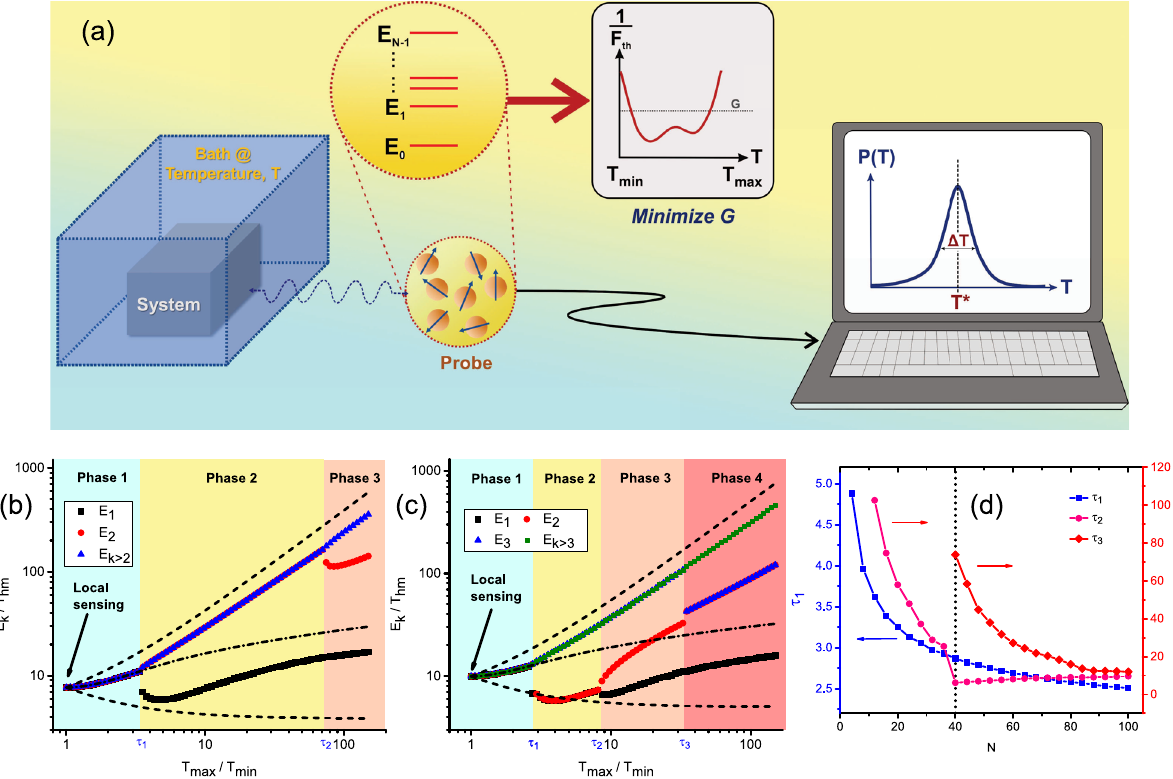
Fig. 1 Global quantum thermometry. a Schematic of our proposal. A probe weakly interacts with the system and thus reaches an equilibrium at the system temperature T 2 ½ T min ; T max (cid:3) . The probe equilibrium state is characterized by a certain energy spectrum with levels E 0 … E N − 1 with N being the number of energy levels. The energy spectrum also determines the thermal quantum Fisher information F th as a function of T . The global thermometry measure G , de fi ned in Eq. (4) as the average uncertainty of the probe, is a property of the probe energy spectrum, and is minimized to achieve the optimal probe. Energy measurements on the probe yield a probability distribution of temperatures with an estimated temperature T * and variance ( Δ T ) 2 . The optimal energies against temperature ratio T max = T min for a general N -level system are obtained for: b N = 16, with E k >2 denoting the degenerate energy levels E = ⋯ = E N − N = 64, with E k E = ⋯ = E N − 3 1 . c >3 denoting the degenerate energy levels 4 1 . In ( b ) and ( c ), the energies are scaled with the characteristic temperature T hm , where T hm is the harmonic mean of T min and T max . The leftmost data point corresponds to the case of the locally optimal thermometer. The dashed lines indicate the approximate bounds for the energies (explained in main text), while the dash-dotted line shows the optimal energy gap for an effective two-level system. The different phases indicate a sudden change in the optimal energy spectrum of the probe. d Critical ratios τ k against N . The critical ratios correspond to the temperature ratios T max = T min at the boundaries of two phases, as labelled in ( b ) and ( c